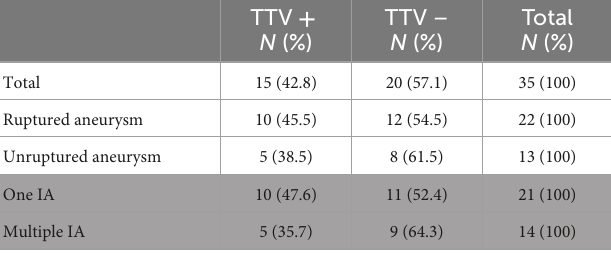
TABLE 2 (White color line) TTV + frequency in patients with ruptured